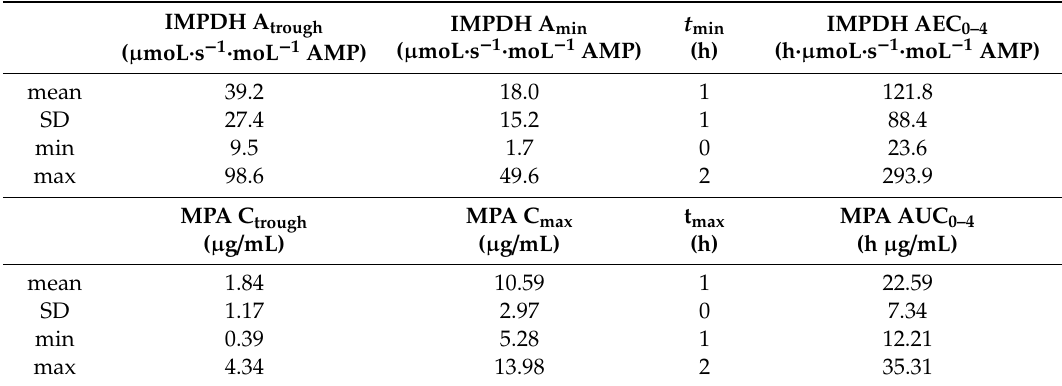
Figure 4. Inosine 5’-monophosphate dehydrogenase (IMPDH) activity and mycophenolic acid (MPA) concentration determined within 4 h after mycophenolate mofetil (MMF) administration. Table 3. Inosine 5’-monophosphate dehydrogenase (IMPDH) pharmacodynamic and mycophenolic acid (MPA) pharmacokinetic parameters in children with nephrotic syndrome treated with mycophenolate mofetil (MMF).